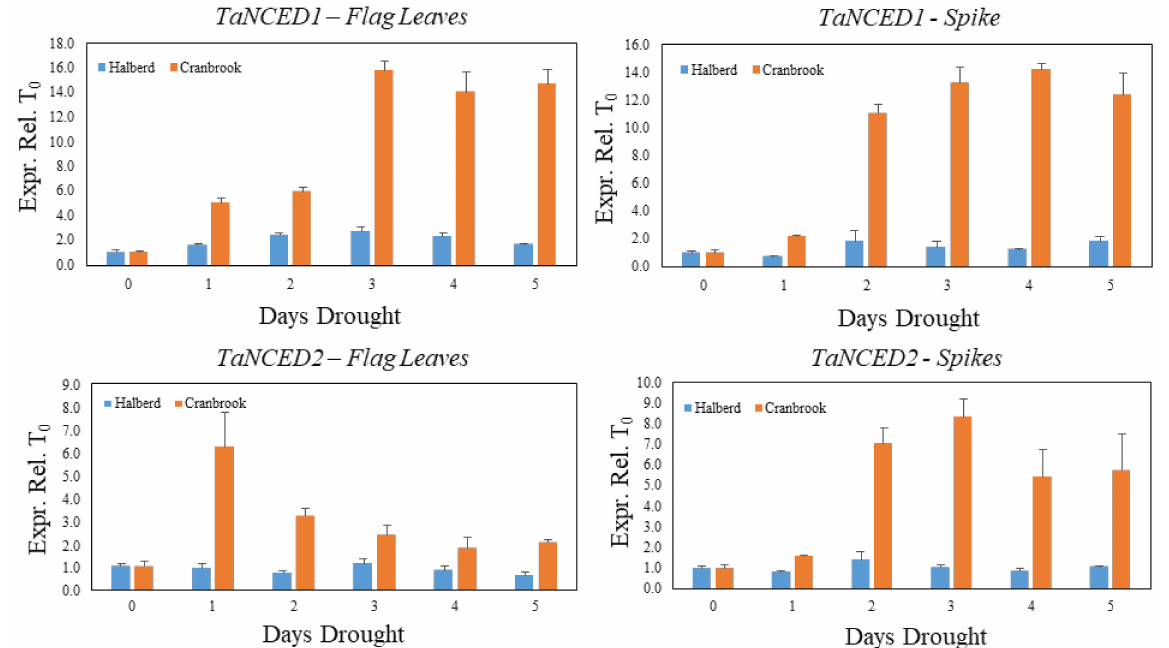
Figure 3. Evolution of TaNCED1 and TaNCED2 gene expression in Cranbrook and Halberd flag leaves and spikes during the 5-day drought time course experiment (Figure 2). Three repeat samples were tested per time point and error bars represent standard